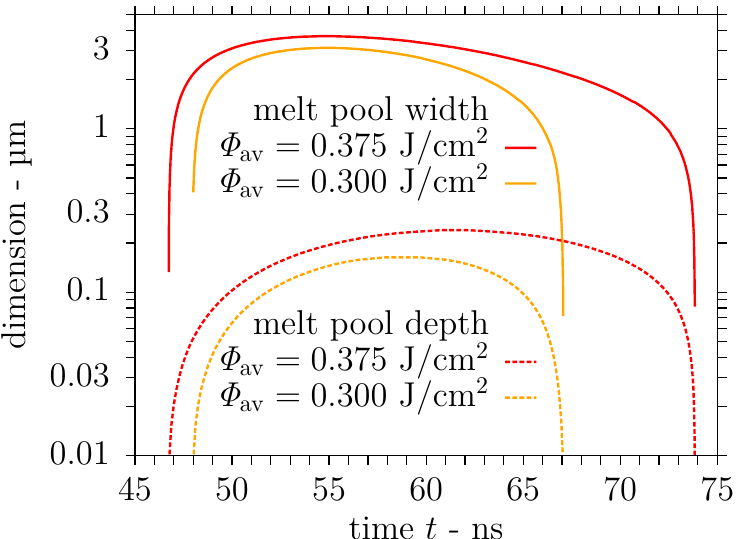
Figure 10. Transient melt pool dimensions predicted by the smoothed particle hydrodynamics (SPH) model of DLIP ( λ = 1053 nm, Λ = 7.2 µm, τ p = 12 ns) on stainless steel using a laser fluence of either 2 Φ 0 = 0.532 J/cm 2 or 2 Φ 0 = 0.665 J/cm 2